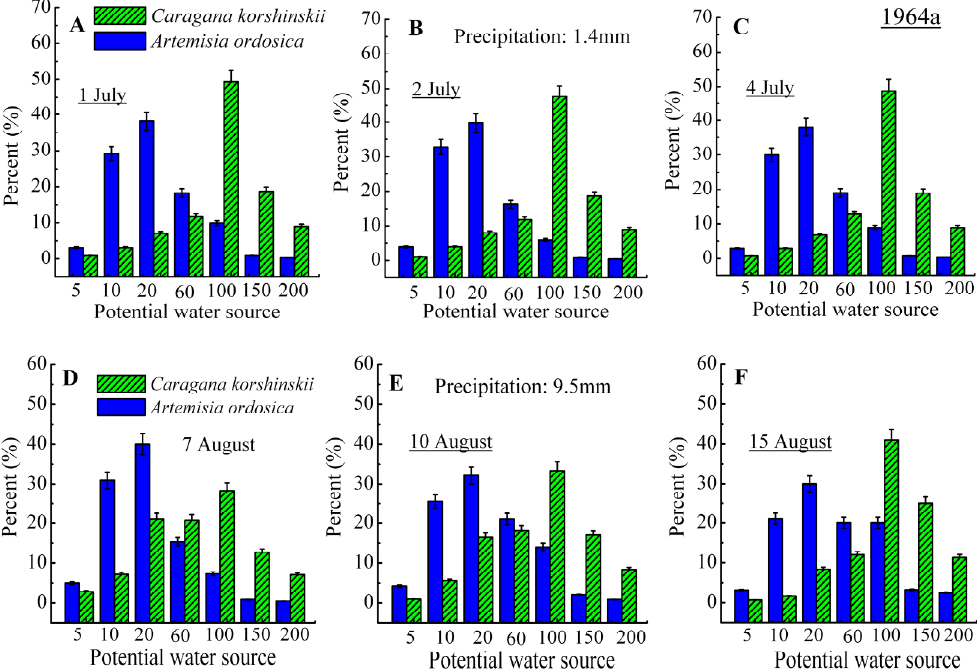
Figure A1. Proportion of potential water source for C. korshinskii and A. ordosica in 1964a revegetated site during a small precipitation event (1.4 mm; A – C ) and a large precipitation event (9.5 mm; D – F